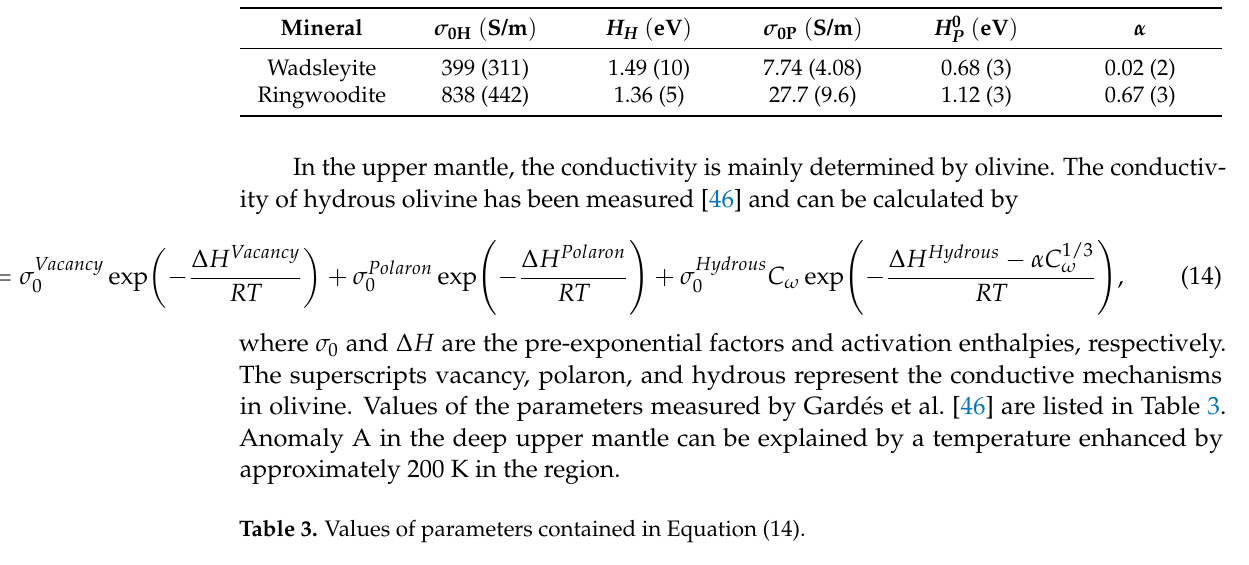
Figure 11. The conductivity cross-section along 27° N ( a ) and the rock physics model used to interpret the conductivity of Anomaly A ( b ). The conductivity of Anomaly A is delimited in the light red zone, with the red line denoting its average conductivity. The black lines with labeled temperatures represent the conductivity of minerals with corresponding temperatures. Table 2. Value of parameters contained in Equation (13). Numbers in parentheses are the errors by nonlinear least squares fitting (1s standard deviation).